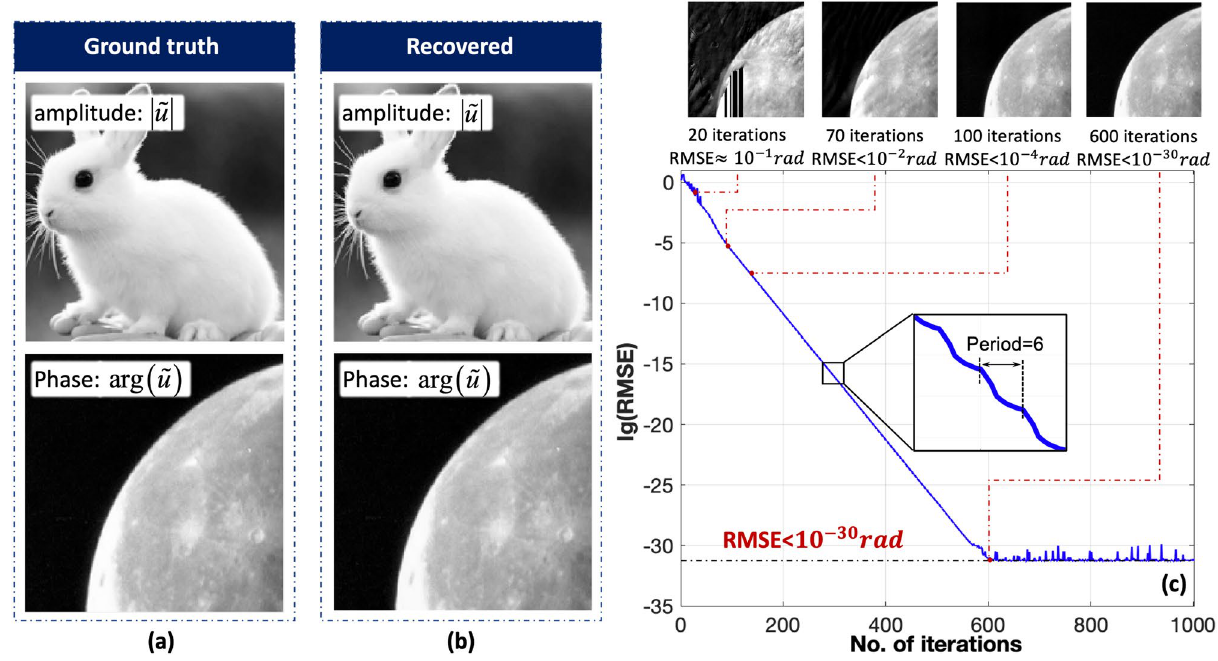
Figure 6. (a) Ground truth of the investigated complex-amplitude object. (b) Recovered complex-amplitude object using six topological modulations after 1000 iterations. (c) lg(RMSE) between the ground truth and recovered phase for iteration numbers from 0 to 1000. arg(): phase